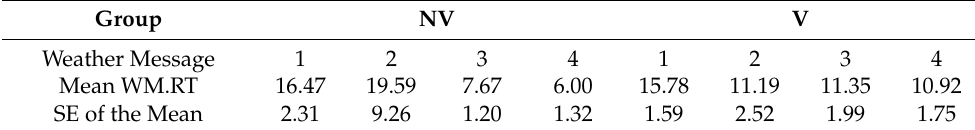
Table 5. Weather message response time (in seconds), divided by group and message number. Group NV V Weather Message